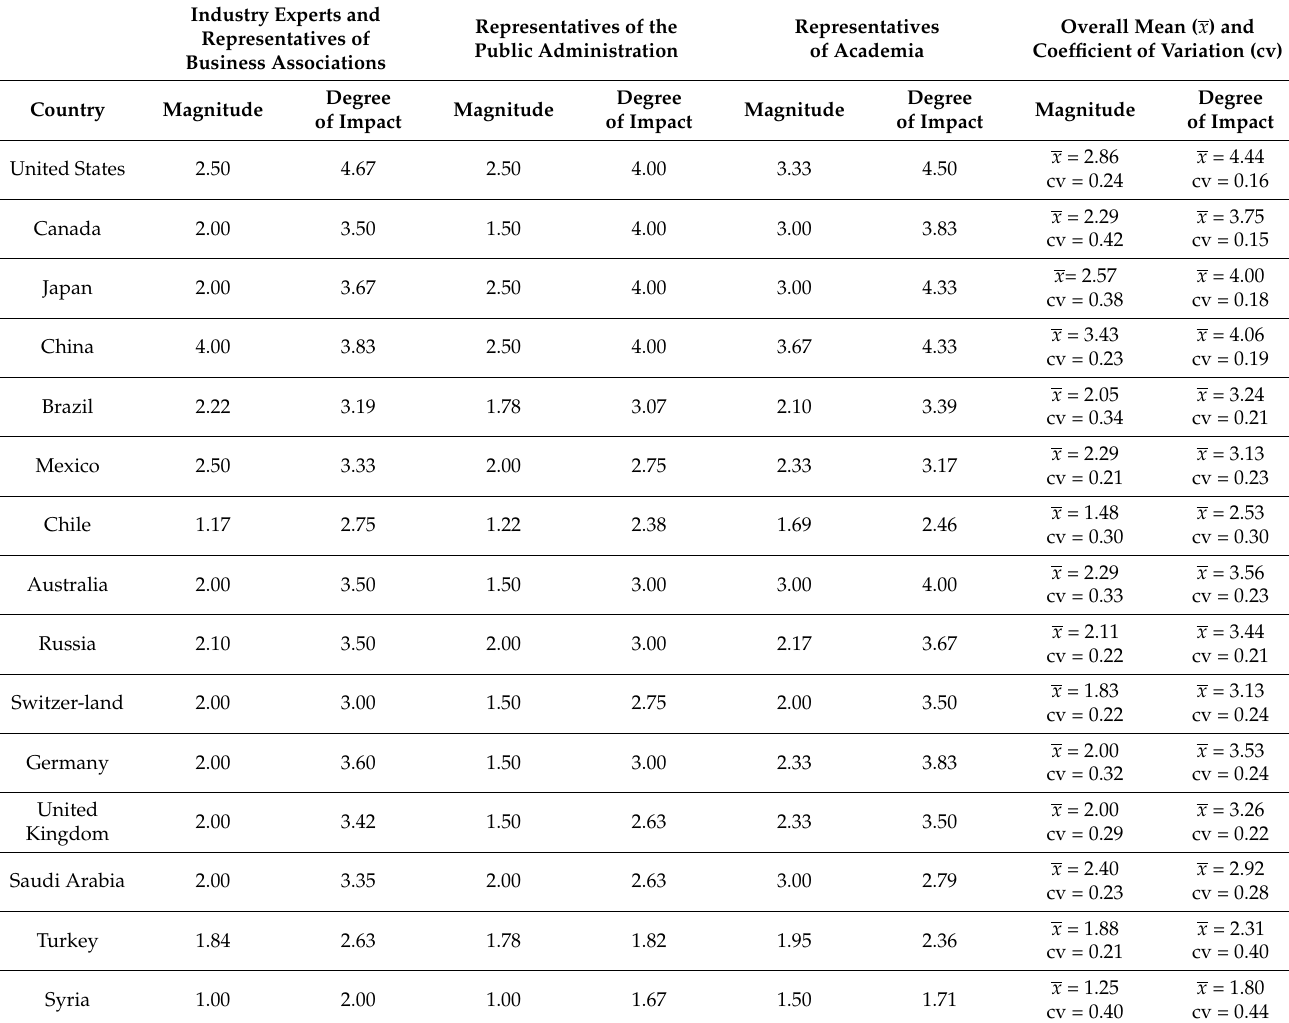
Table A2. Magnitude of the annual increase in the demand for olive oil and its degree of impact on Spanish